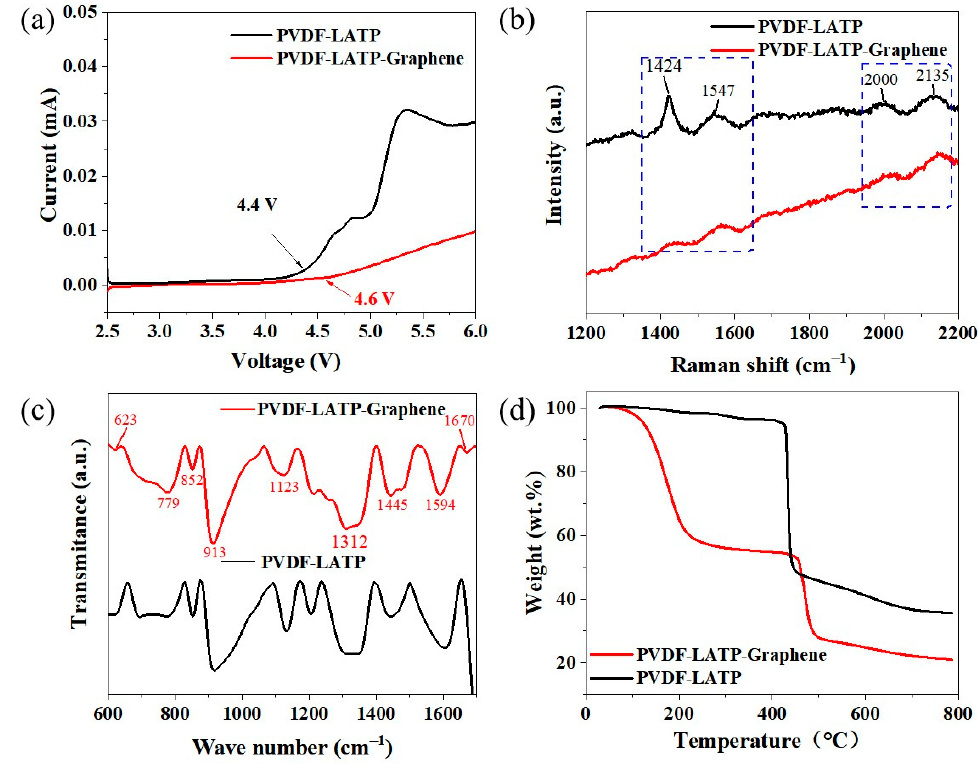
Figure 4. ( a ) Electrochemical windows, ( b ) Raman spectra, ( c ) FTIR spectra and ( d ) TG diagram of the PLL and PLLG composite solid electrolyte.